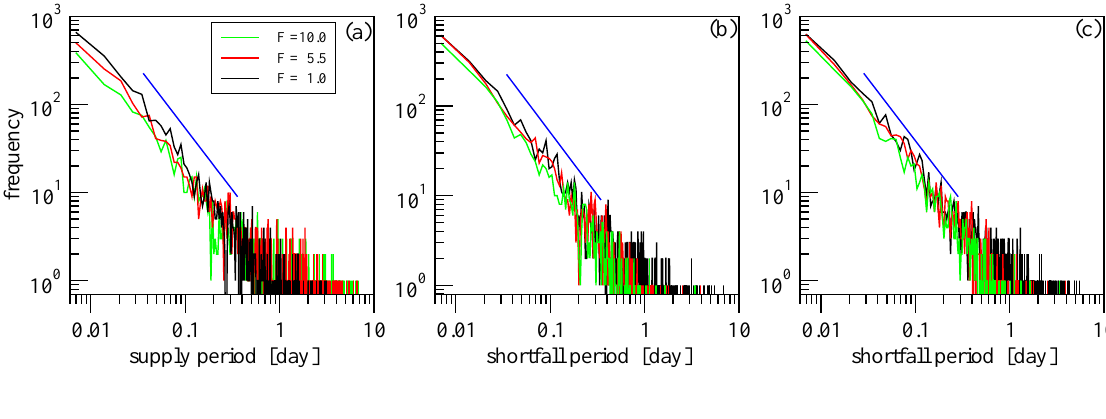
) and shortage sup and the aggregated K